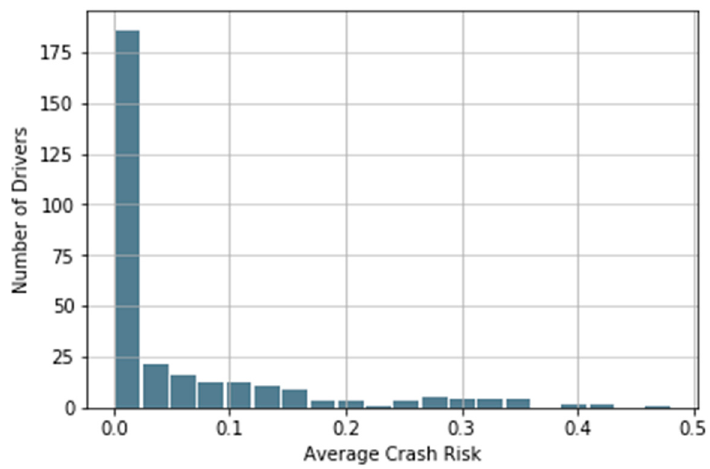
Figure 3. Histogram of Average Crash Risk (ACR).